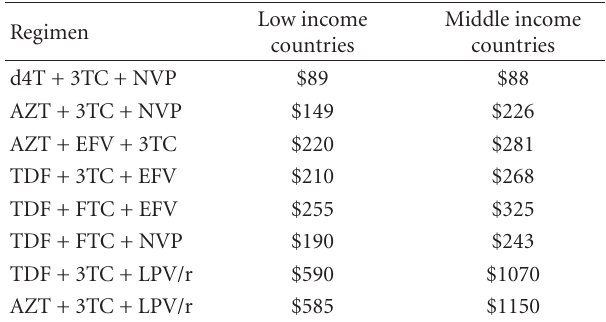
Table 1: Antiretroviral costs per patient per year for low- and middle-income